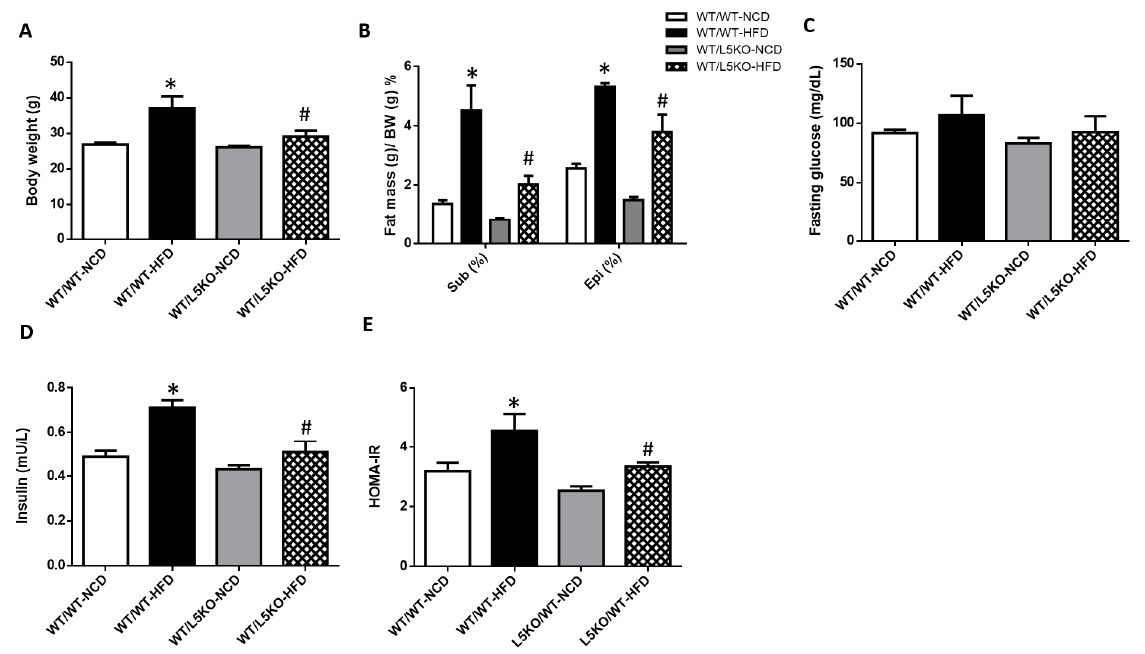
Figure 4. Tissue-specific CCL5 deletion protects against HFD-induced obesity and insulin resistance. WT/WT and WT/L5KO (tissue-specific CCL5 knockout) mice were fed an HFD or NCD ( n = 6–8 per group) for 20 weeks. ( A ) Body weight; ( B ) subcutaneous and epididymal fat mass per gram body weight; ( C ) fasting blood glucose; ( D ) insulin; ( E ) HOMA-IR. All data are presented as mean values ± SEM from at least 6 mice in each group. Statistical differences are indicated: *, p < 0.05 vs. WT/WT-NCD #, p < 0.05 vs. WT/WT-HFD.